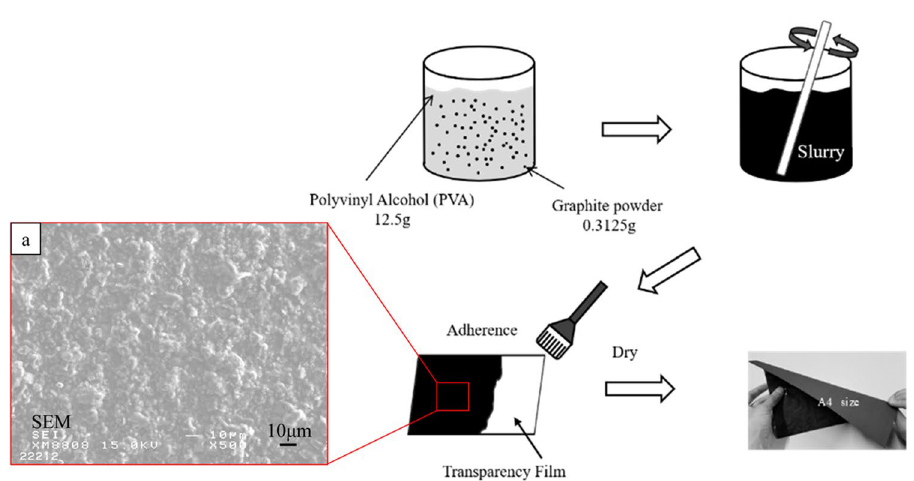
Figure 1. Schematic illustration of fabricating processes of Graphite powder sheet: ( a ) the SEM image of graphite powder